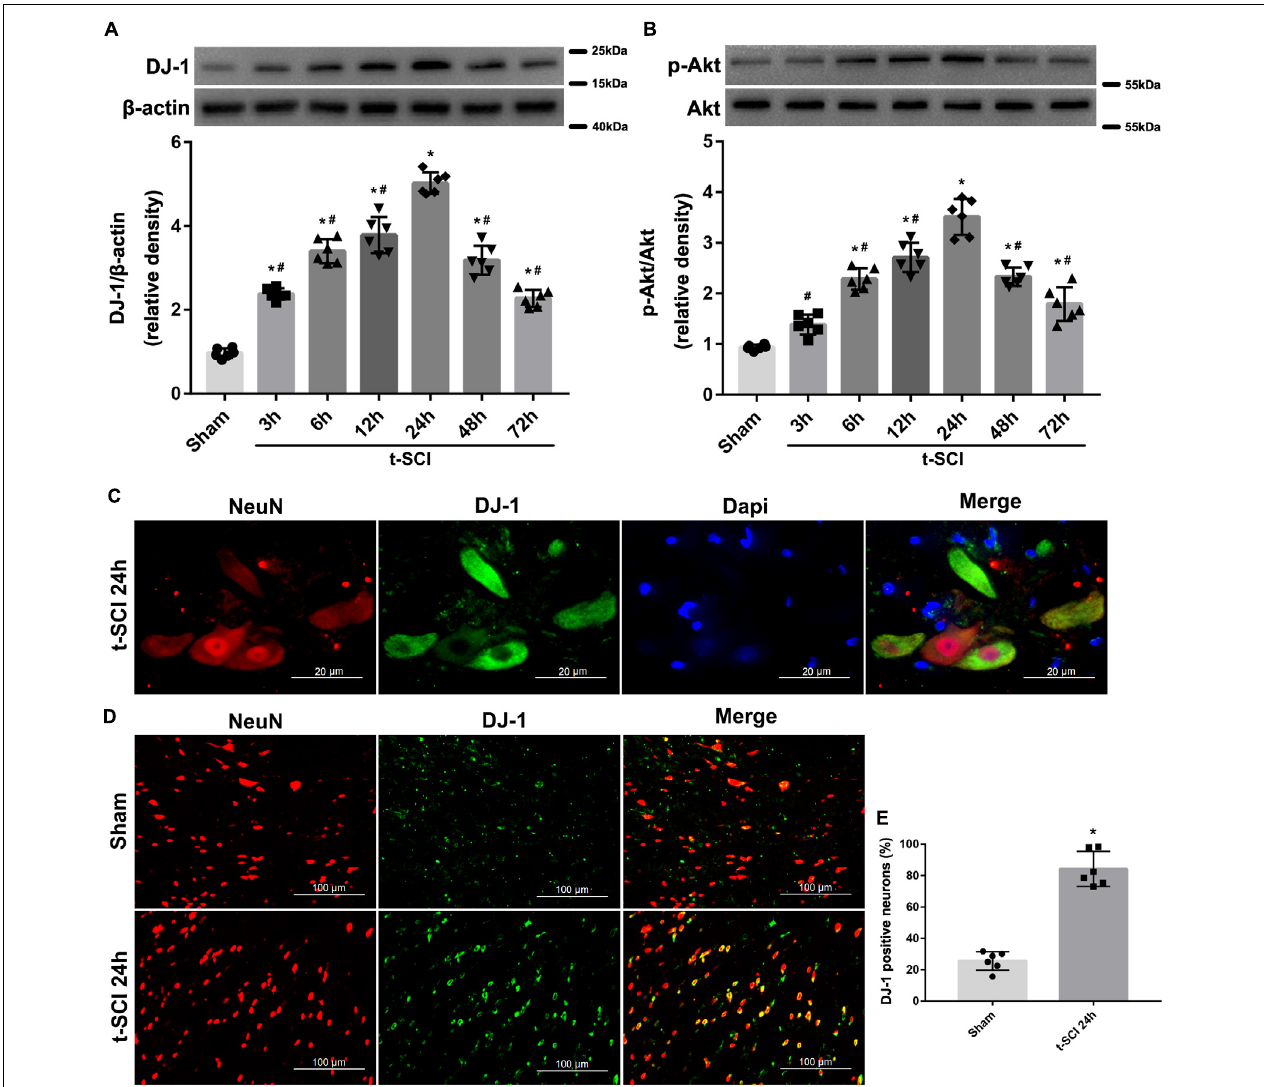
FIGURE 3 | Representative Western blots showing the time course of changes in the levels of DJ-1 and p-Akt. The expression level of DJ-1 was significantly elevated at 3 h and peaked at 24 h after t-SCI, and then significantly decreased after 24 h post-injury (A) ; the expression level of p-Akt was significantly increased at 6 h and peaked at 24 h after t-SCI, and then significantly decreased after 24 h post-injury (B) . N = 6 for each group. Data is expressed as mean ± SD and analyzed by one-way ANOVA and Bonferroni’s post hoc multiple comparisons test. Representative IF staining micrographs showing the proportion of DJ-1-positive neurons in each group at 24 h post-injury. DJ-1 was expressed mainly in neurons (C) and proportion of DJ-1-positive neurons was increased after t-SCI (D,E) . N = 6 for each group. Data is expressed as mean ± SD and analyzed by t -test. ∗ p < 0.05 versus sham; # p < 0.05 versus t-SCI 24 h.